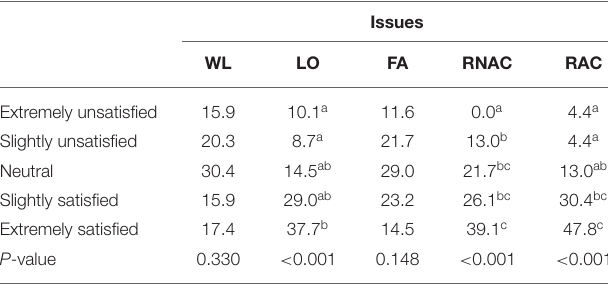
TABLE 3 | Farmers’ satisfaction (frequency, %) in relation to different